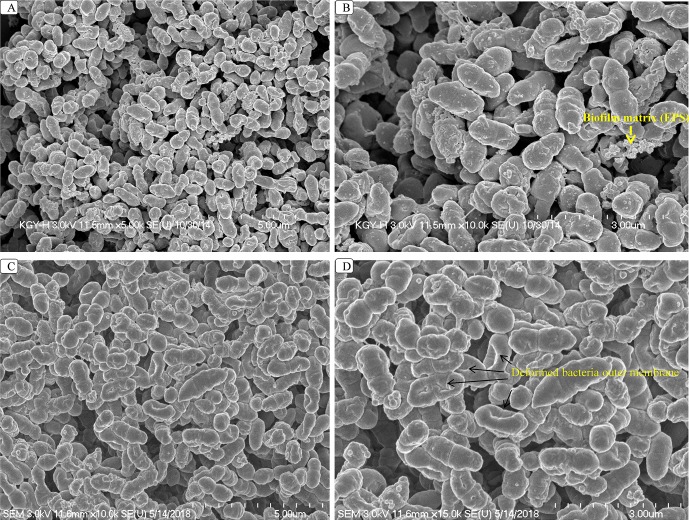
SEM analysis of S. pneumoniae biofilms treated with 2 × MIC of ε-viniferin (2). Images A and B are SEM images of control biofilms. Images C and D are SEM images of viniferin-treated biofilms. In viniferin-treated biofilms, cells appear shrunken, and cell membranes were damaged (indicated by arrow). SEM images were 5 and 3 µm.